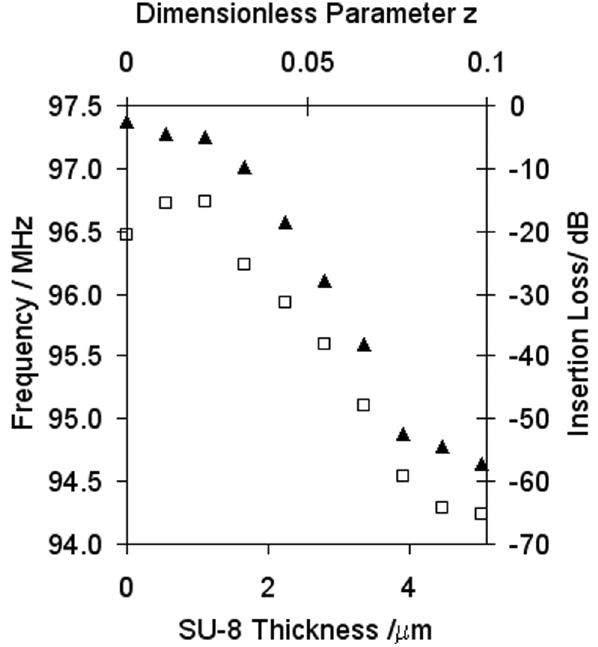
Figure 1. Signal characteristics covering the first mode of an SU-8 guiding layer Love wave device. Frequency (closed triangles) and insertion loss (open squares) shown as a function of guiding layer thickness and dimensionless parameter z = d / λ